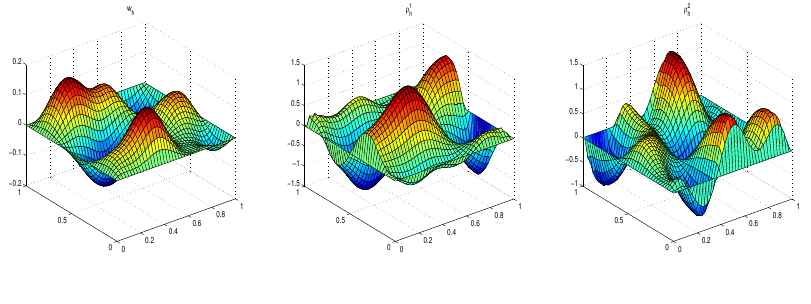
Figure 2. Numerical results by Least-squares algorithm.